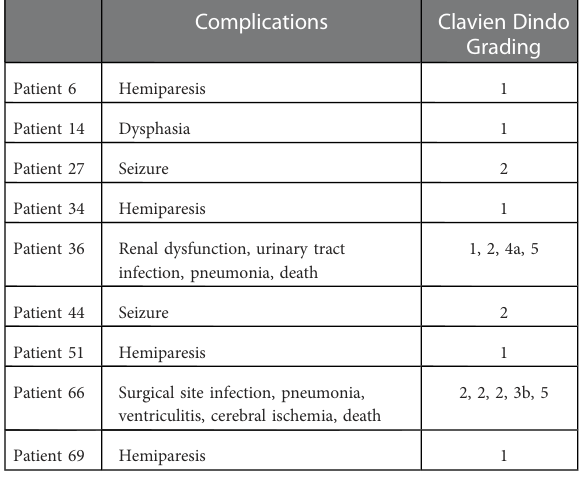
TABLE 3 Adverse events: data is shown for each individual patient (who experienced an AE) as adverse event including corresponding grading according to the clavien dindo grading